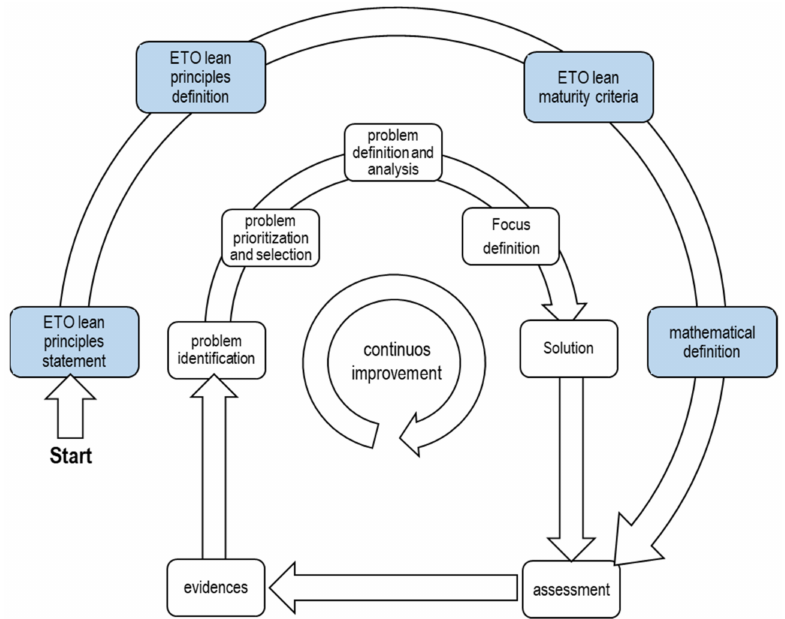
Figure 4. The two concentric virtuous loops concerning the (external) assessment model and the (internal) interested organization,